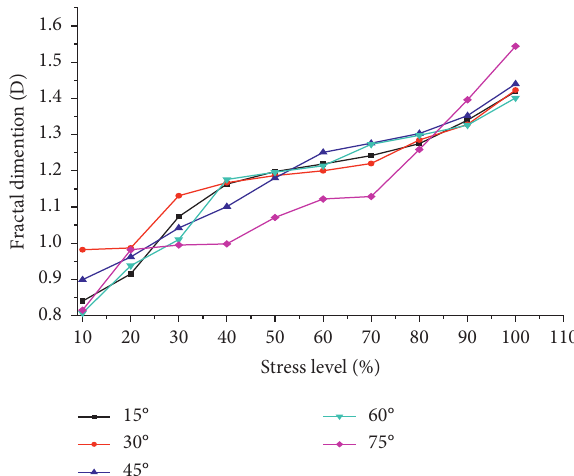
Figure 13: Relationship between fractal dimension and different stress